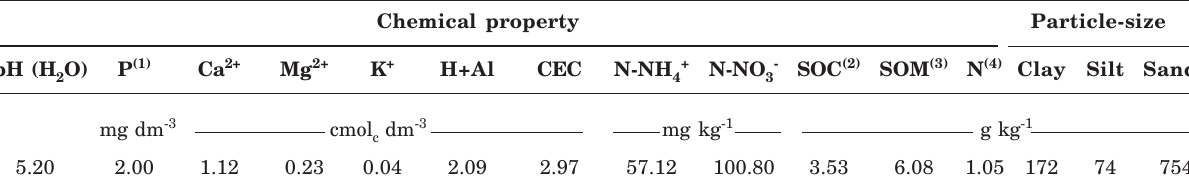
(1) P-Mehlich-1; (2) SOC: soil organic carbon; (3) SOM: soil organic matter (Embrapa, 1999). (4)